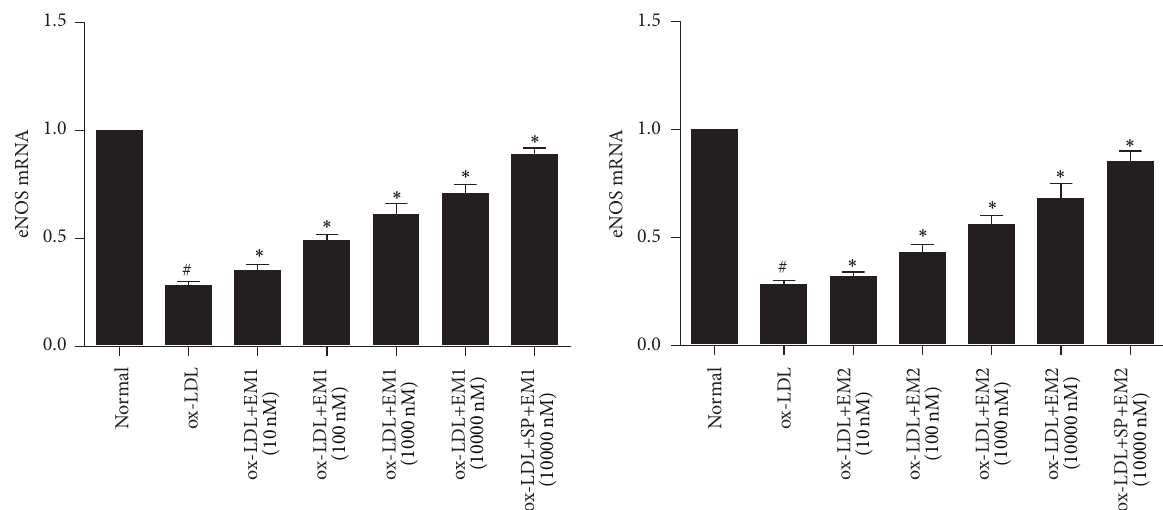
Figure 5: Effect of EM1/EM2 on eNOS mRNA in HUVECs treated by ox-LDL. All data is expressed as mean ± SD. ∗ 𝑃 < 0.05 versus control. # 𝑃 < 0.05 versus ox-LDL.